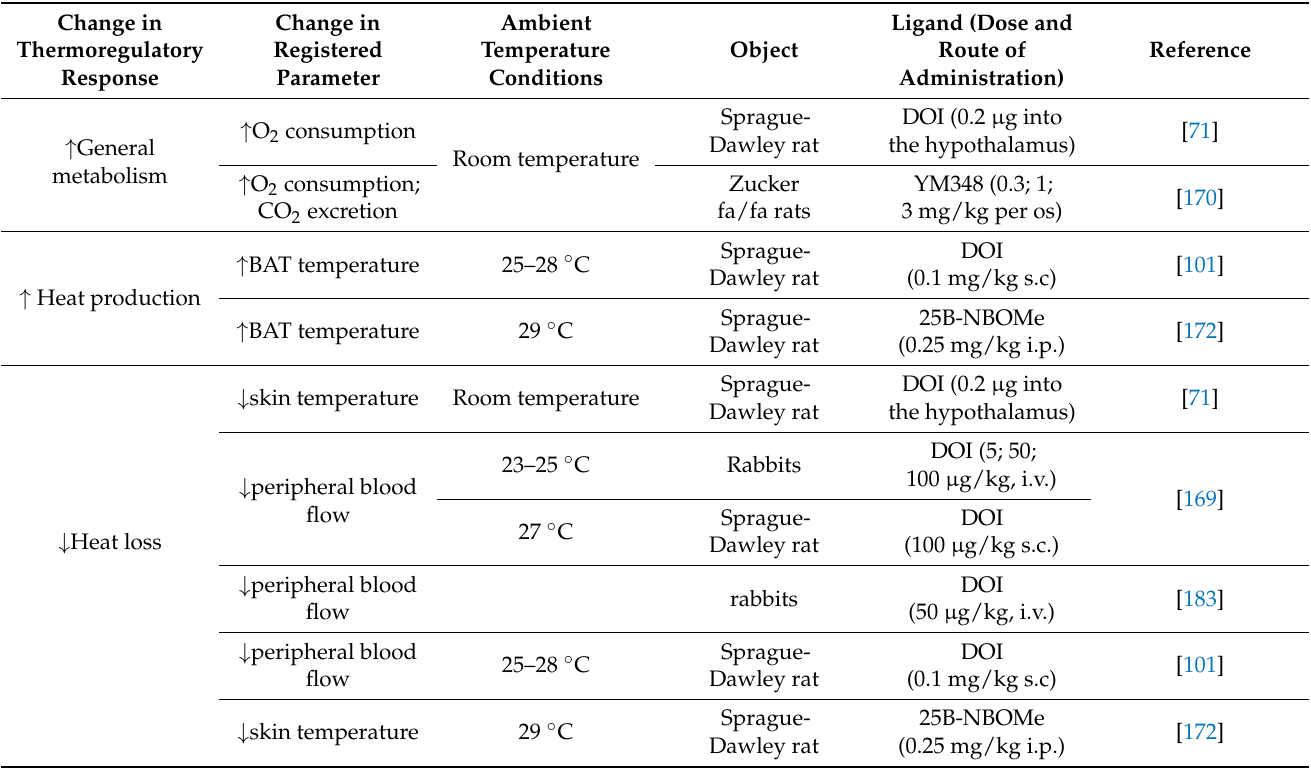
Table 6. Effect of 5-HT 2 receptor activation by their selective agonists on thermoregulatory responses in warm-blooded organisms. Change in Thermoregulatory